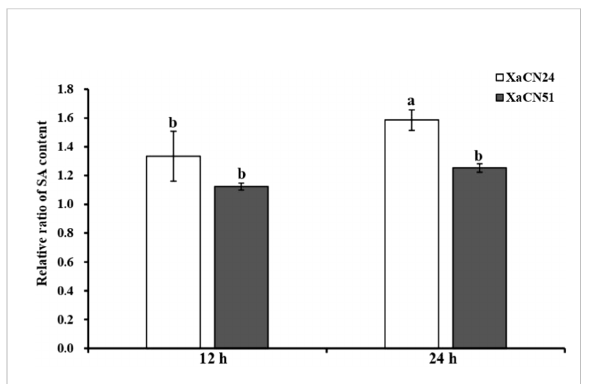
FIGURE 6 Changes of relative ratio of salicylic acid (SA) content in sugarcane leaves inoculated with two strains of Xanthomonas albilineans (XaCN24 and XaCN51). Each vertical bar represents the mean ± standard deviation of fi ve leaf subsamples collected 12 and 24 hours after inoculation and three technical replicates per subsample. Each leaf subsample is issued from a pooled sample of fragments collected from 35 inoculated leaves. Means with the same letter are not signi fi cantly different at P = 0.05 according to Duncan ’ s